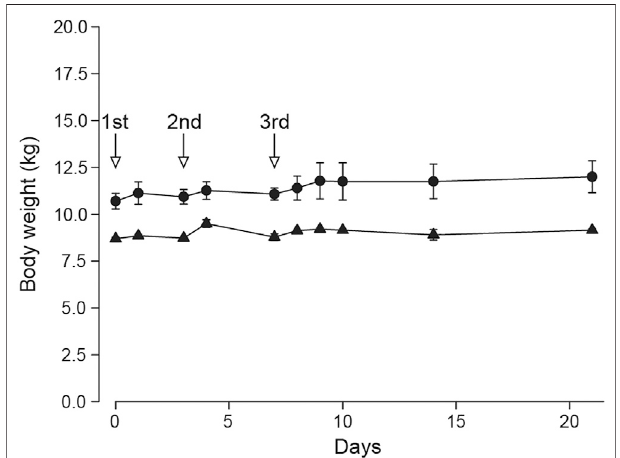
FIGURE 4 | Normal body weight of beagle dogs treated with Acer tegmentosum Maxim. water extract in the acute toxicity study. Male and female animals (n (cid:2) 2/gender) were sequentially administered an increasing dose of Acer tegmentosum Maxim. water extract (ATWE; 1st administration, 1,000 mg/kg BW; 2nd, 2,000 mg/kg BW; and 3rd, 5,000 mg/kg BW) with an interval of 3 – 4 days after the 1st and 2nd administration and 14 days after the 3rd administration for monitoring clinical signs and body weight. All animals showed a normal range of body weight during and after treatment of ATWE.